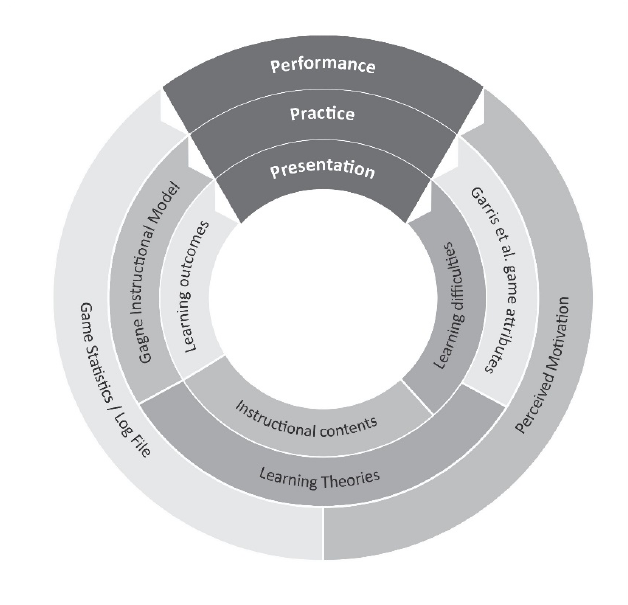
Figure 2. Designed Serious Games (SG) model for learning